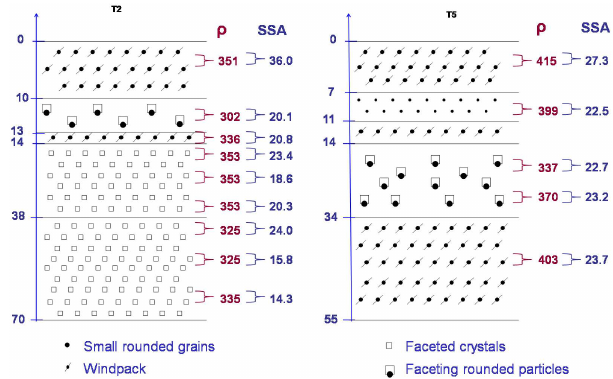
Fig. 7. Stratigraphy, density ( ρ) in kgm − 3 and SSA in m 2 kg − 1 of pits T2 and T5.